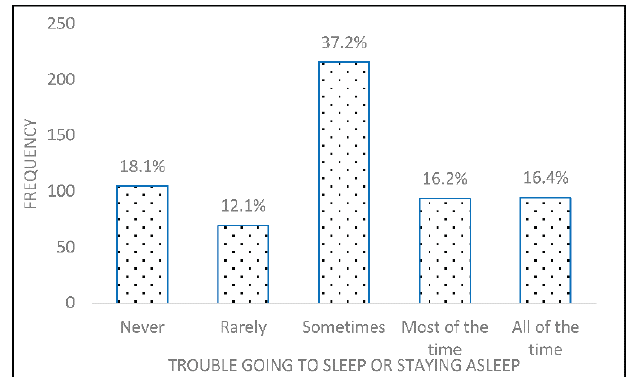
Figure 1. Trouble going to sleep or staying asleep.